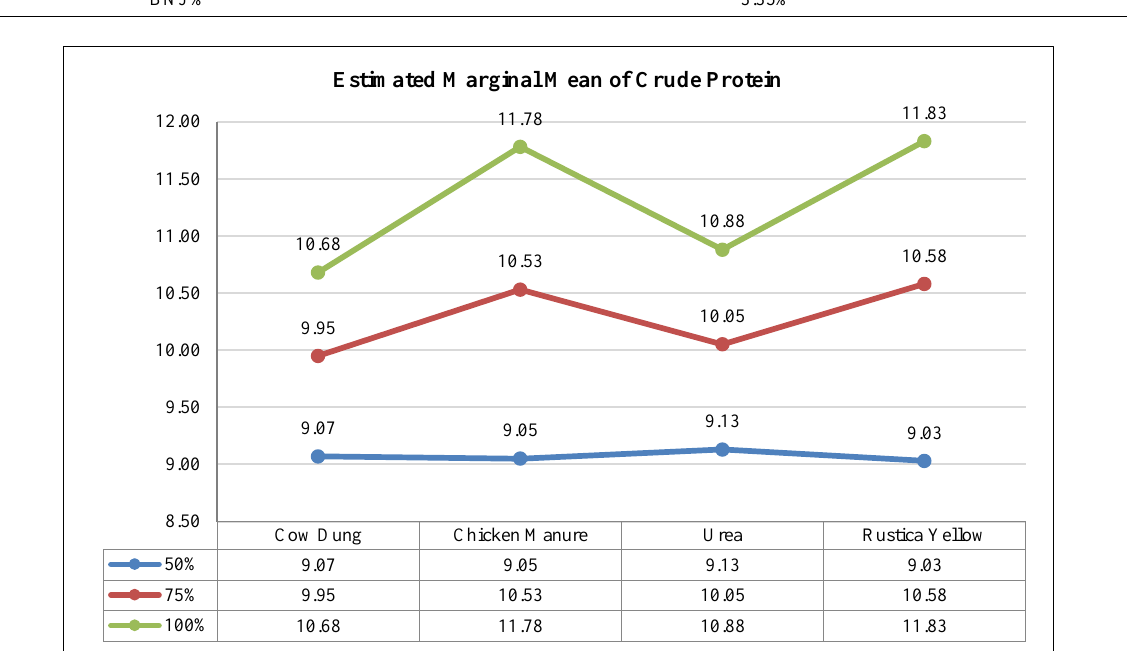
Figure 8. Nitrogen Sources Effect on Crude Protein